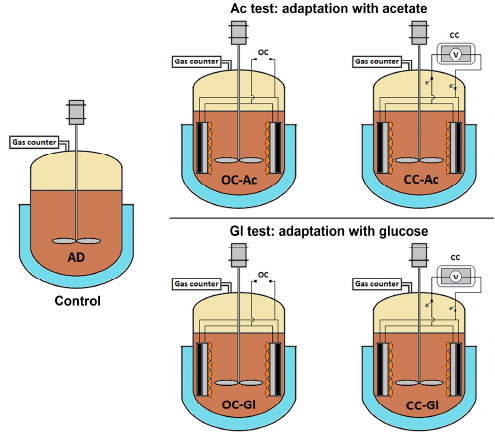
experiments tested: AD (conventional anaerobic digester), OC-Ac, and OC-Gl (combined AD-BES